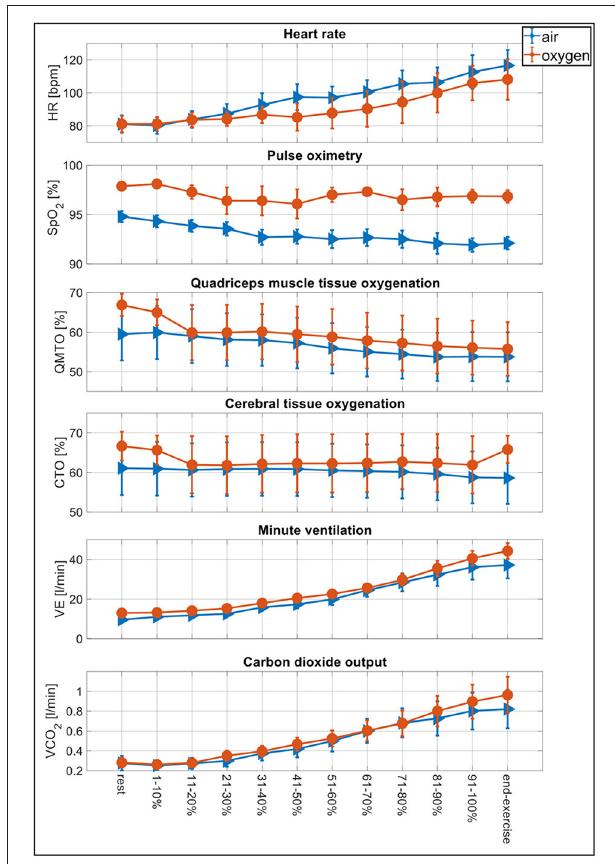
FIGURE 3 | Physiological changes during the incremental exercise test. Physiological changes of the incremental exercise test comparing tests with air (blue) vs. oxygen-enriched air (red) by computing means over each 10% fraction of maximal exercise duration individually achieved with ambient air, i.e., 1–10%, 11–20%, etc., up to 91–100% of total exercise duration and end-exercise defined as the mean over the final 30s of the test. HR, heart rate; SpO 2 , arterial oxygen saturation; QMTO, quadriceps muscle tissue oxygenation; CTO, cerebral tissue oxygenation; V’E, minute ventilation; V’CO 2 , carbon dioxide